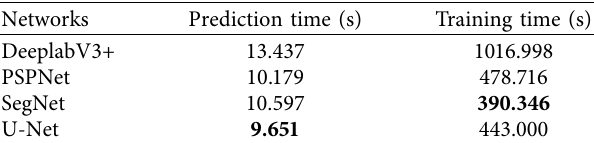
Table 4: Prediction time of four kinds of